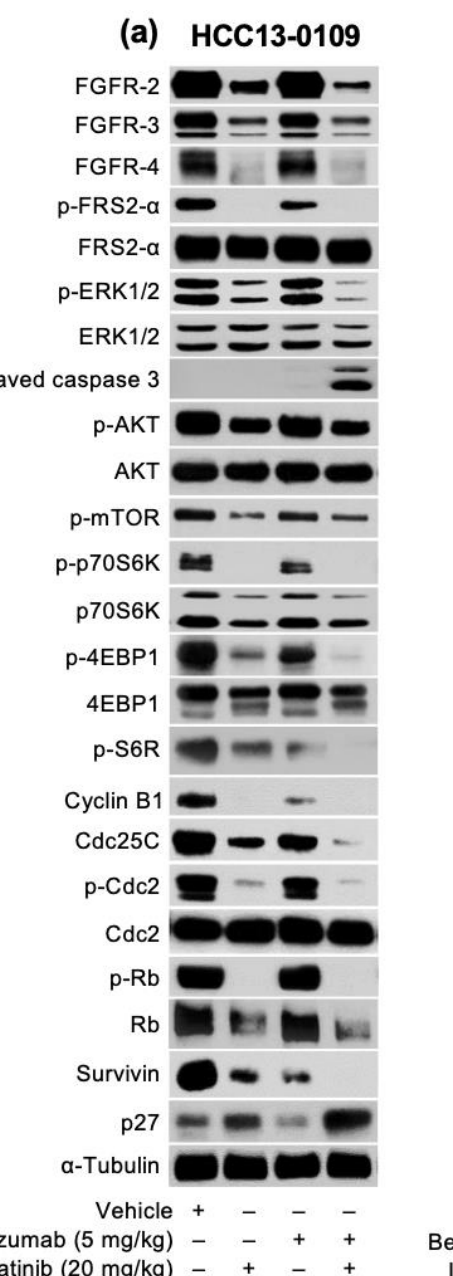
Figure 3. Effects of Infigratinib/Bevacizumab on expression of the fibroblast growth factor receptor (FGFR) signaling pathway and proteins involved in cell cycle, proliferation, and apoptosis in HCC13-0109 and HCC06-0606 models. Mice bearing indicated xenografts were treated as described in Figure 1 for 5 days. Tumors were collected 2 h after the last treatments and tumor lysates subjected to Western blot analysis, as previously described [23]. Representative blots for HCC13-0109 ( a ) and HCC06-0606 ( b ) are shown.